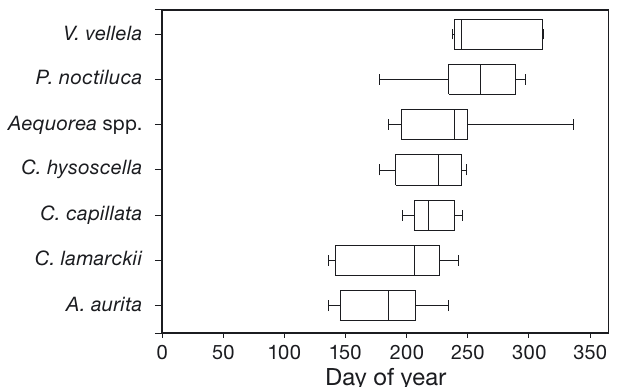
Fig. 2. Median stranding date (± 5th and 95th percentiles), illustrating the seasonality of all stranded jellyfish species encountered during 2009 to 2011 (all zones combined). Boxes represent first and third quartiles (50% of all strand- ing events), with 90% of all stranding events bounded by the error bars. All species names are given in Table